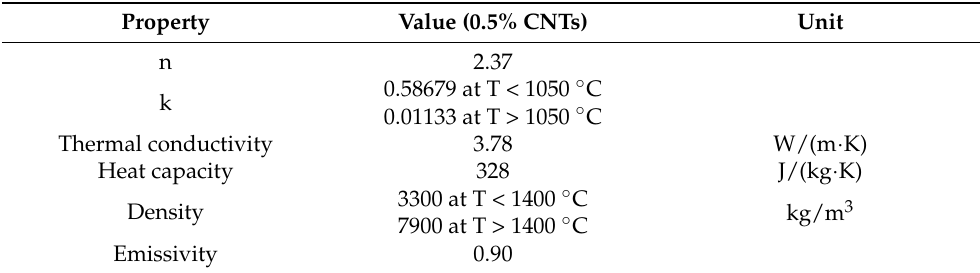
Table 4. Material properties of CNT/PZT used in the finite element simulation.